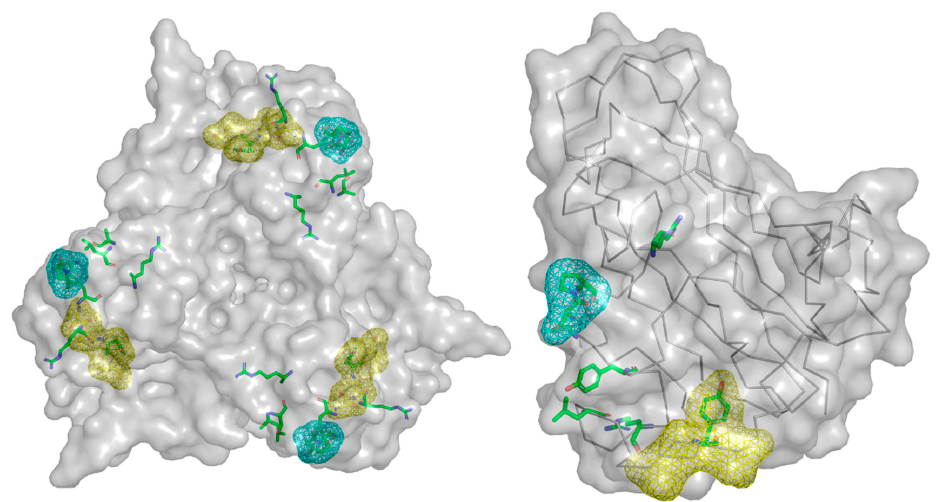
Figure 3. Coxsackie and Adenovirus Receptor (CAR) interacting residues within the Ad5 fiber knob domain. Known CAR interacting residues are shown as green sticks. The blue and yellow mesh shows the surface of the KO1 and Δ TAYT mutations, respectively. Structure from PDB: 1KNB.